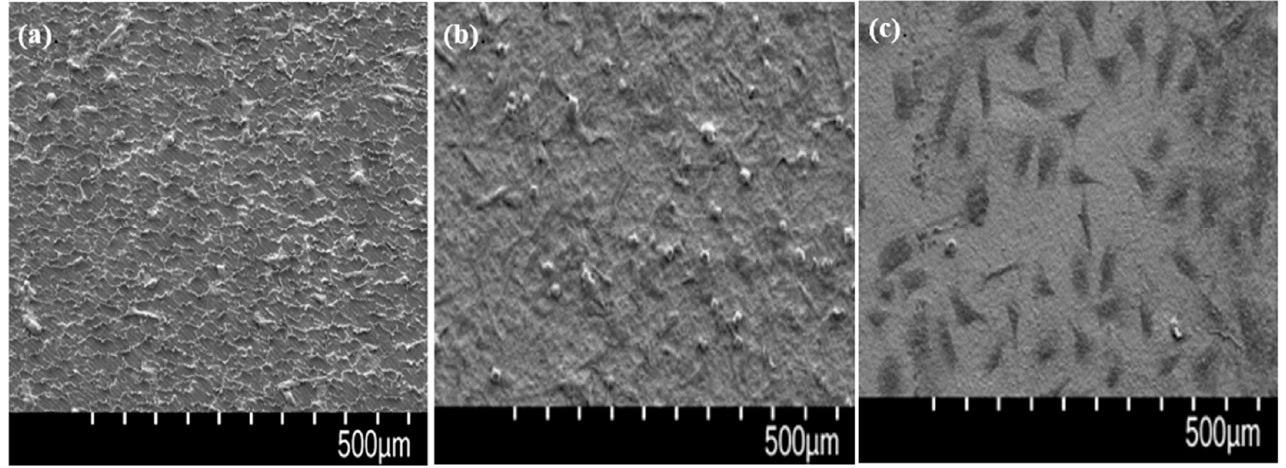
Figure 7. SEM images of MC3T3-E1 cell adhered to pristine PEEK ( a ), P-PEEK ( b ), and P-PEEK-Col ( c ) after 6 h culture.